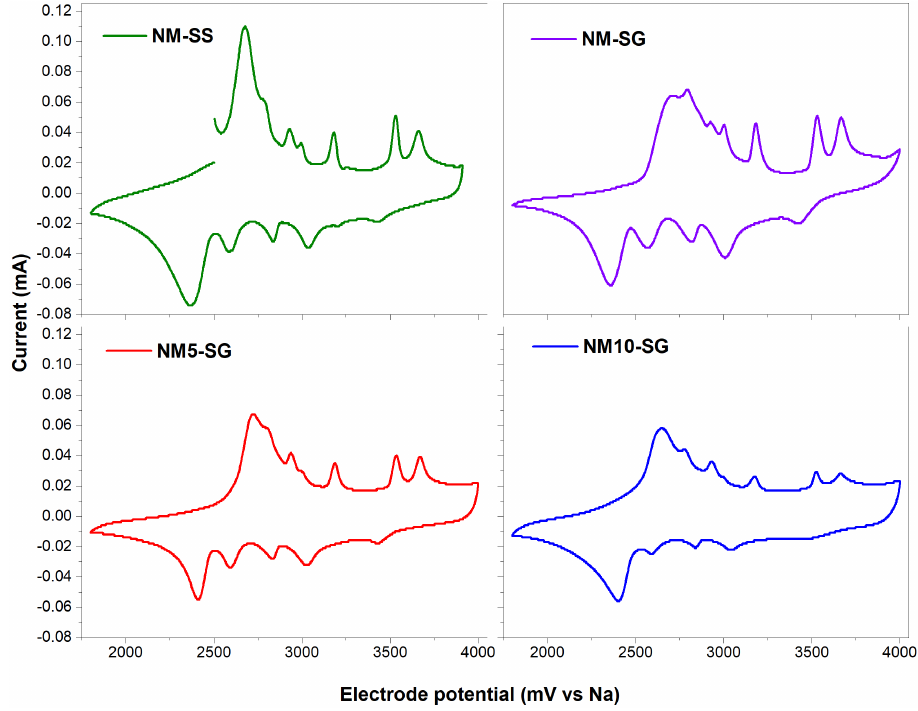
Figure 4. Cyclic voltammetries of the four materials performed with a scan rate of 0.05